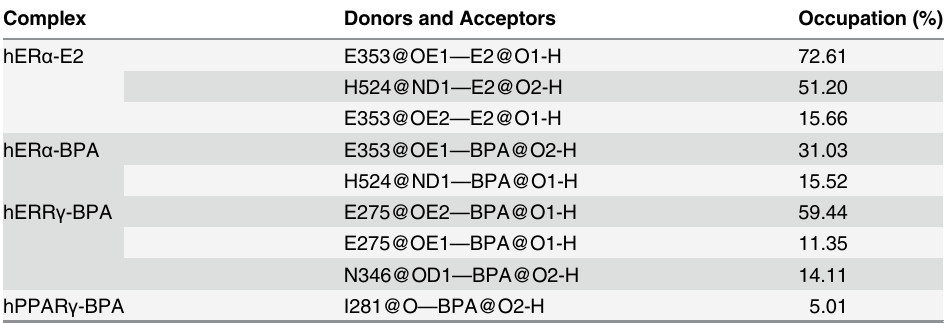
Table 2. Occupation of H-bond between the key residues of receptor and ligand in the four systems.